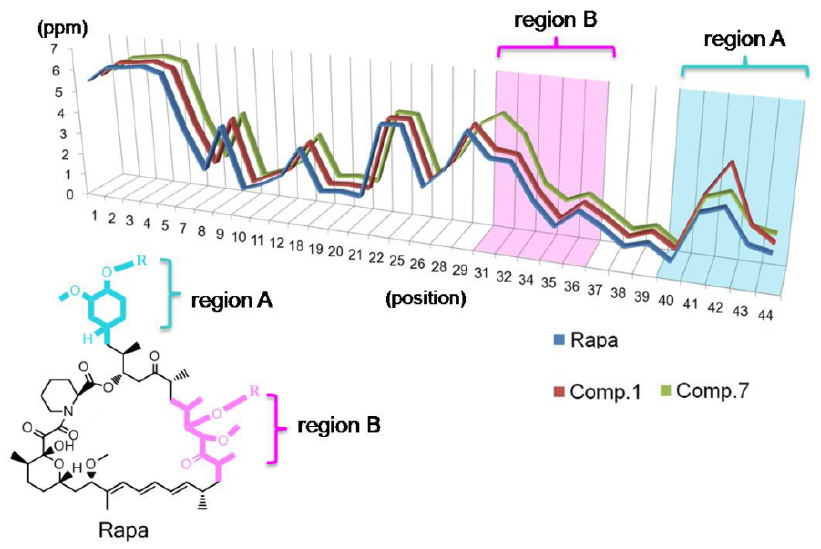
Figure 6. The curves (chemical shifts vs . positions) recording the chemical shifts (ppm) for different positions of protons of Rapa (blue curve), 1 (red curve) and 7 (green curve). Regions A and B were marked by blue and red,